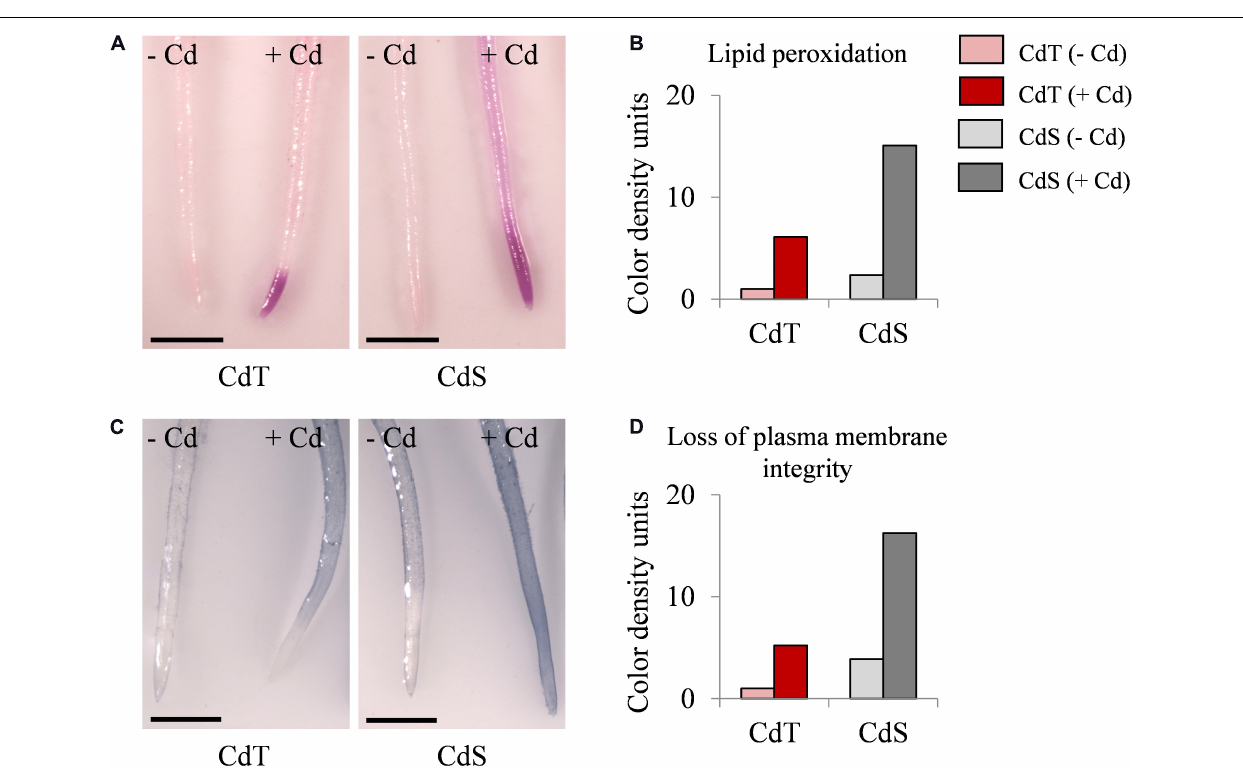
FIGURE 8 | Lipid peroxidation and loss of plasma membrane integrity in seedling roots of M. truncatula cultivars CdT (tolerant) and CdS (sensitive) grown in glass containers in the absence or presence of 100 µ M CdCl 2 for 12 h. (A) Staining with Schiff’s reagent for lipid peroxidation assessment. (C) Staining with Evans Blue for plasma membrane integrity assessment. Quantification of color developed with Schiff’s reagent (B) and Evans Blue (D) on 1 cm root tips. Scale bar corresponds to 1